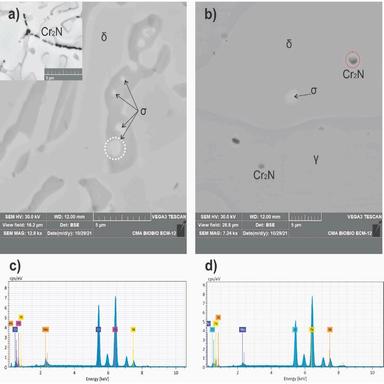
SEM-BSE images of SDSS-Nb, a) SDSS-Nb heat-treated at 1030 ◦C; b) SDSS-Nb heat-treated at 1060 ◦C; c) EDS spectrum of σ phase in SDSS-Nb heat-treated at 1030 ◦C zone with white segmented line circle in figure "a"; d) EDS spectrum of Cr2N phase in SDSS-Nb heat-treated at 1030 ◦C zone with red segmented line circle in figure "b". (For interpretation of the references to colour in this figure legend, the reader is referred to the Web version of this article.)